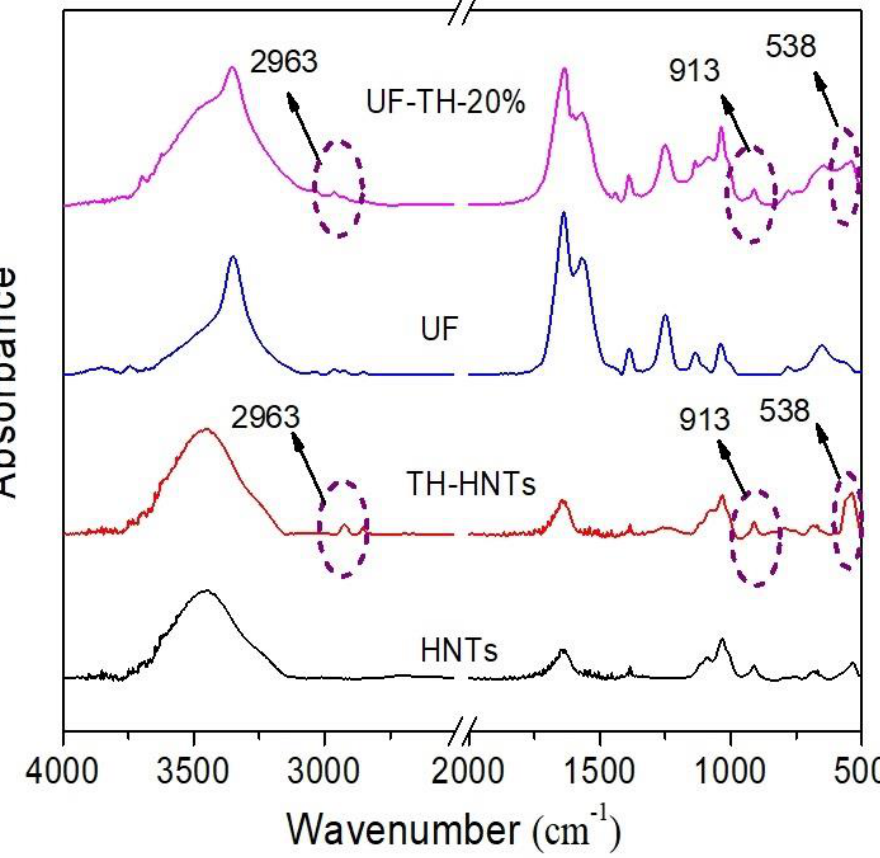
Figure 1. FTIR spectra of HNTs, TH-HNTs, UF, and